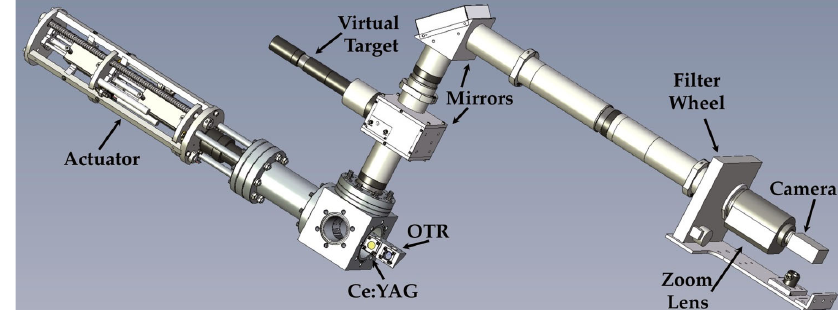
FIG. 2. The Fermilab prototype station with cube and actuator, screens, virtual target, optics, filter wheels, zoom lens, and camera.